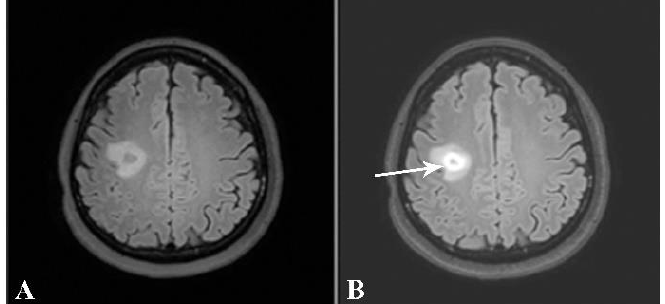
Figure 8. Axial precontrast FLAIR ( A ) and postcontrast FLAIR ( B ) images show complete ring-enhancing lesion (arrow) with minimal surrounding vasogenic edema. No significant pressure effect is shown. A presumptive diagnosis of small tumefactive MS was made, although there were no other lesions, either in the brain or in the spinal cord. The patient was given high-dose intravenous steroid.